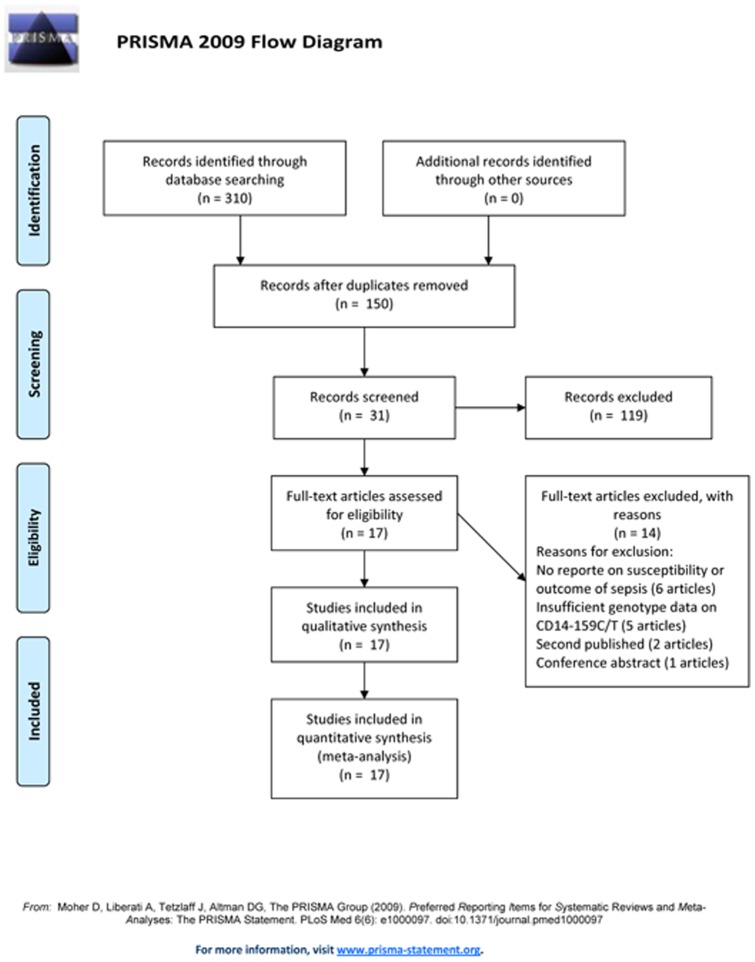
Flow diagram of study identification.